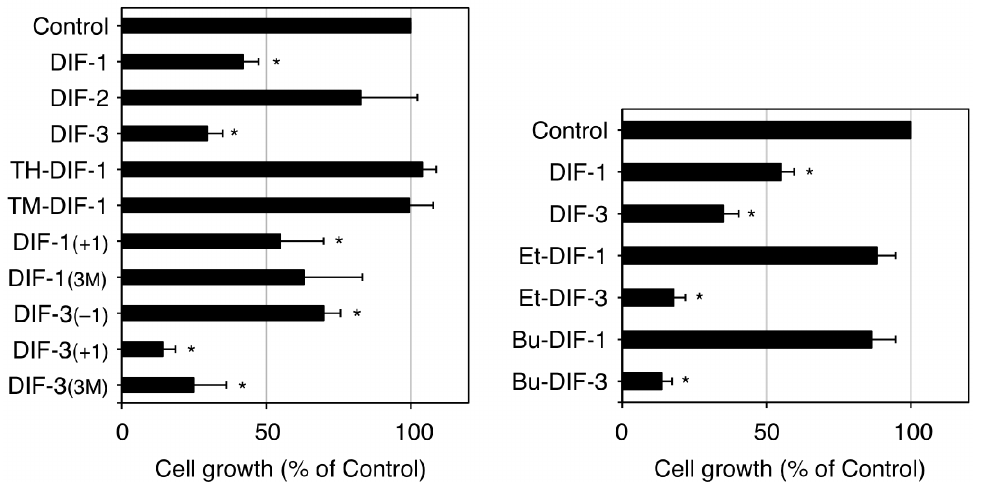
Figure 3. Effects of DIFs on the growth of K562 human leukemia cells (adapted from Gokan et al. [73]). Cells were incubated at 37 ◦ C for 3 days in the presence of 0.15% EtOH (vehicle; Control) or 15 µ M of one of the DIF derivatives and then the relative cell number was assessed. Means and SD (bars) of three independent experiments are shown. * p < 0.05 versus Control (by t -test; two-tailed, unpaired). DIF-3 and its derivatives but not DIF-1 and its derivatives, showed strong anti-proliferative activity in K562 cells.